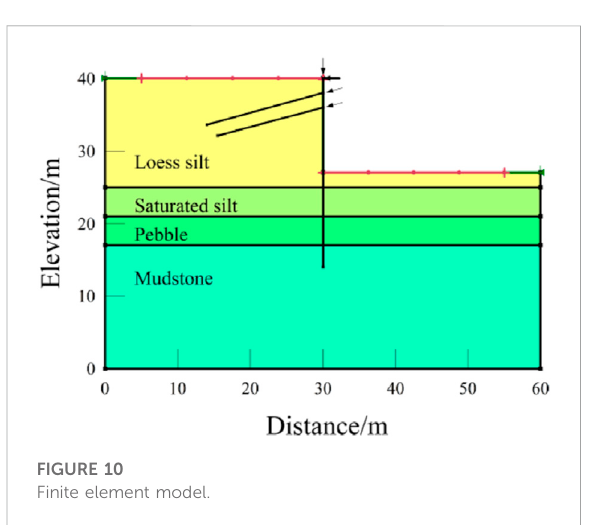
FIGURE 10 Finite element model.